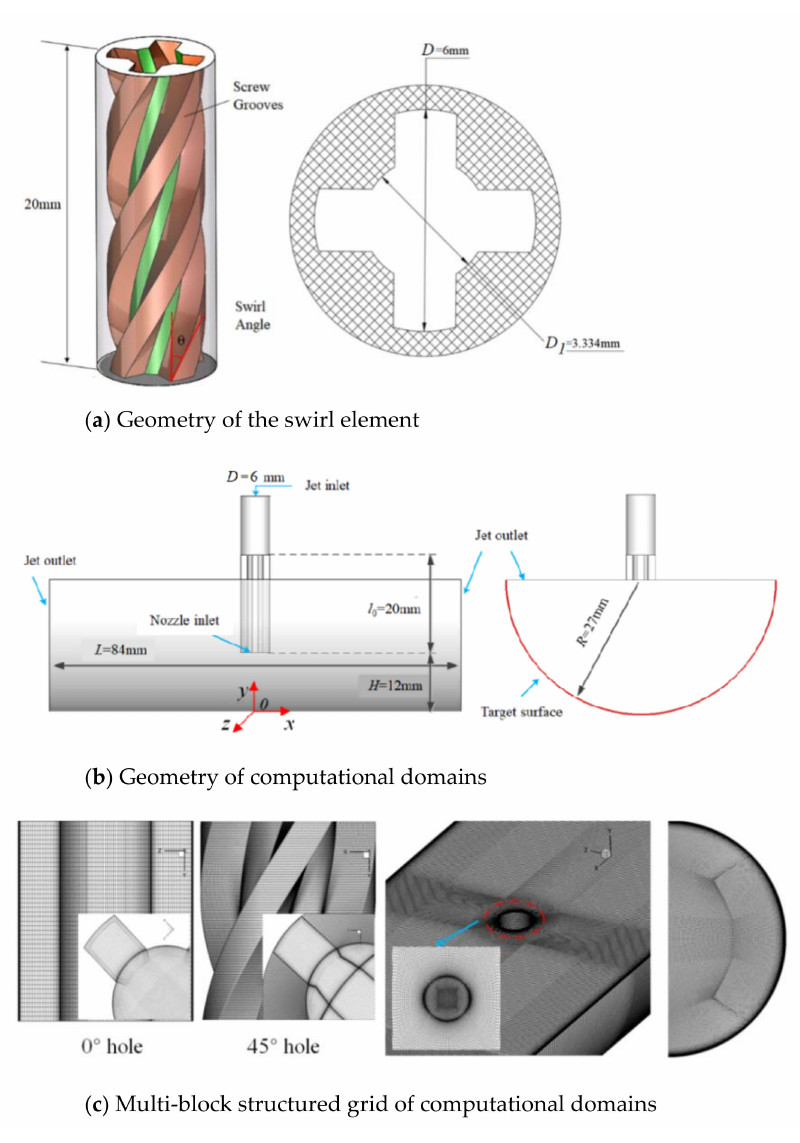
Figure 5. Geometrical structure and computational